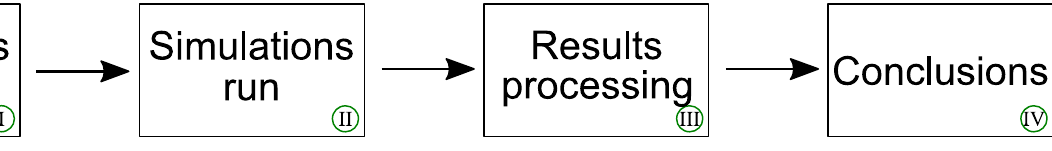
Figure 3. Scheme of the four stages of simulation studies.